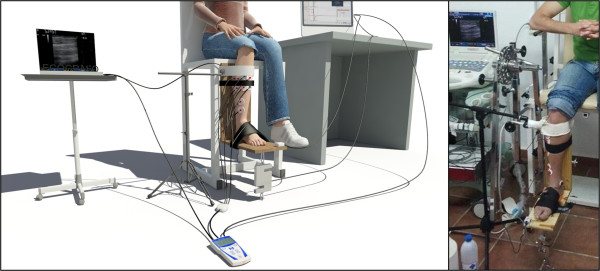
Experimental setup.